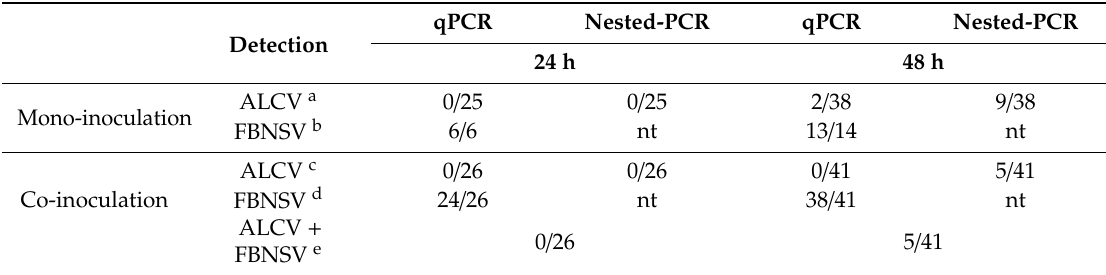
Table 1. FBNSV and ALCV DNA detection in broad bean leaf discs after aphid inoculation. qPCR Nested-PCR qPCR Nested-PCR Detection 24 h 48